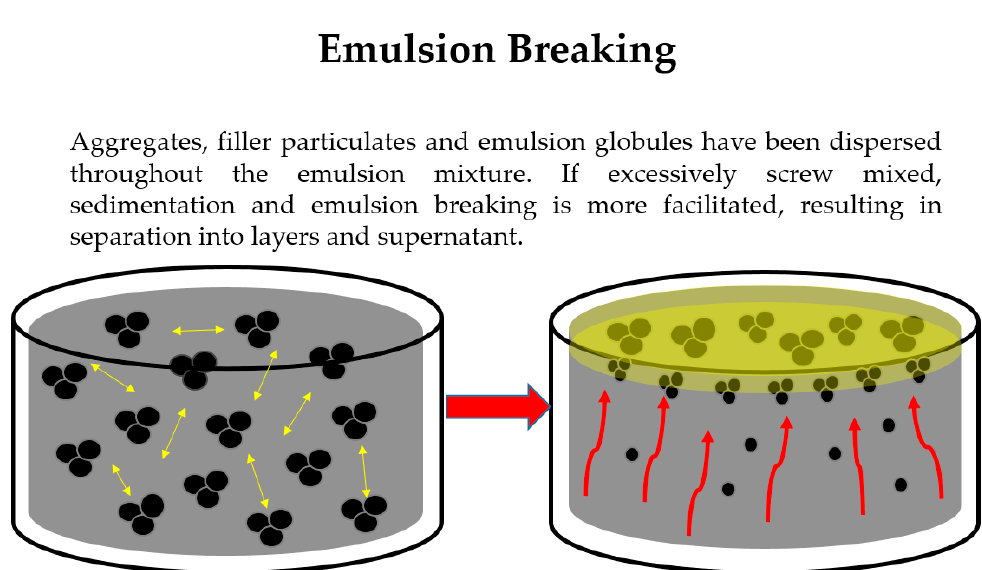
Figure 5. Property changes in SPRG following the screw-mixing process; facilitated emulsion breaking following filler particle and globule dispersion due to screw mixing.